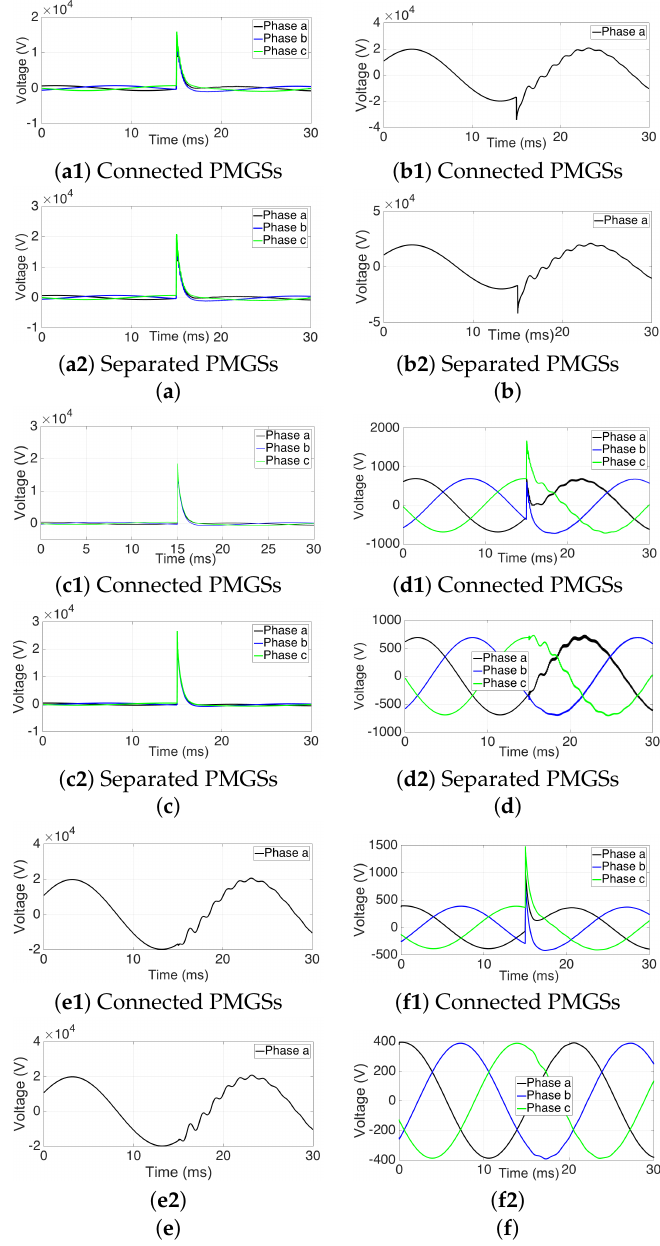
Figure 17. Impact of direct lightning on overvoltages. ( a ) LV side of the first tower; ( b ) HV side of the first tower; ( c ) control circuit of the first tower; ( d ) LV side of the second tower; ( e ) HV side of the second tower; ( f ) control circuit of the second tower. Table 1. Peak voltage values of LV/HV sides of boost transformer and control circuit with indirect